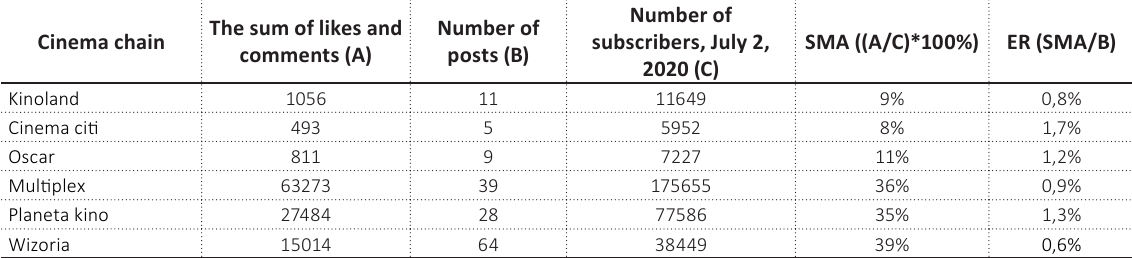
Table 4. Analysis of the number of audience contacts on Facebook